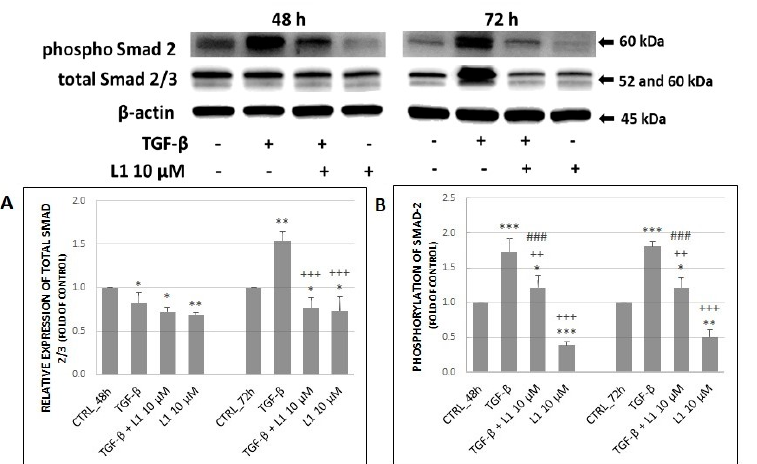
Figure 5. Changes in expression and phosphorylation of Smad proteins ( A ) along with corresponding densitometry analyses ( B ) of western blot results. All after 48 h and 72 h of L1 treatment. Representative data of three independent experiments are presented. Significantly different * p < 0.05, ** p < 0.01, *** p < 0.001 vs. untreated cells (control); ++ p < 0.01, +++ p < 0.001 vs. TGF- β ; ### p < 0.001 vs. L1.